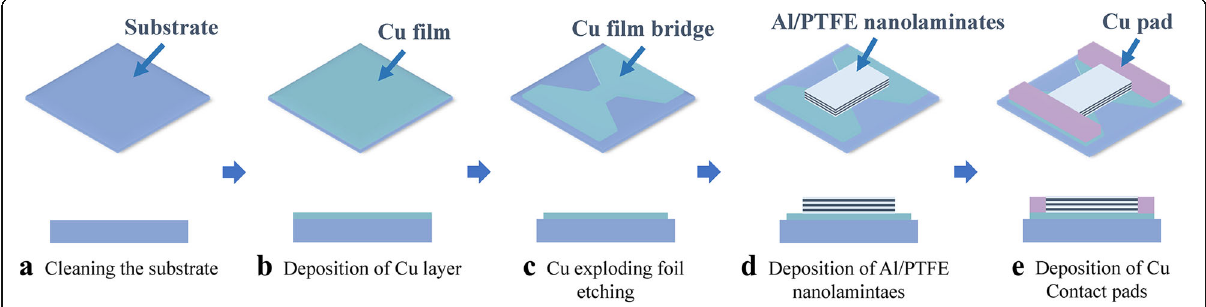
Fig. 1 Schematic drawing and fabrication process flow of the (Al/PTFE) n /Cu film